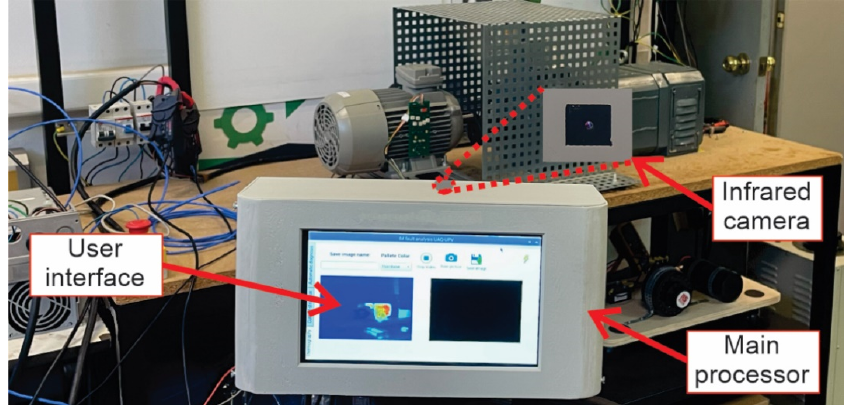
Figure 14. Real test bench used to validate the smart sensor based on infrared thermography.